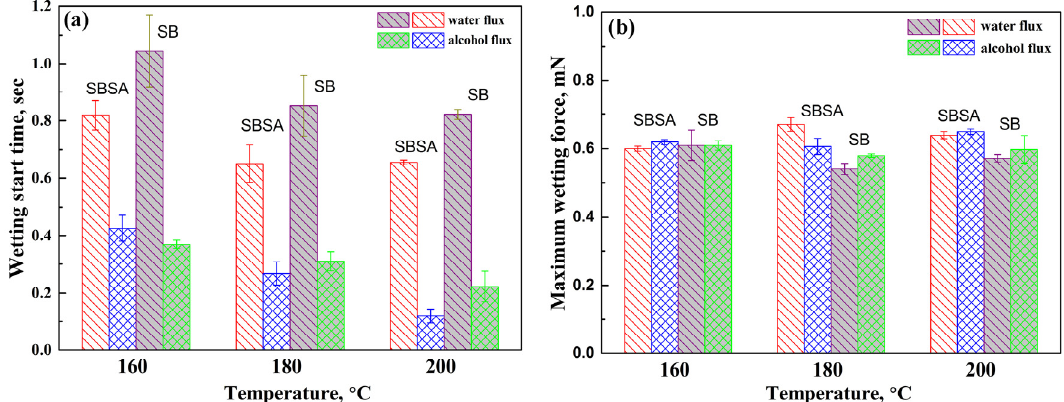
Figure 2. Comparison on the wettability of Sn-38Bi-1.5Sb-0.7Ag and Sn-58Bi solder: ( a ) wetting time and ( b ) wetting force.